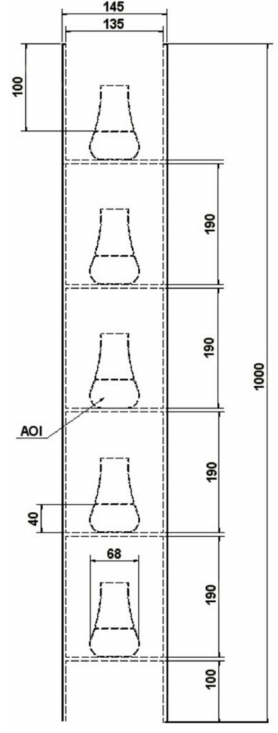
Figure 1. Technical drawing of the proposed